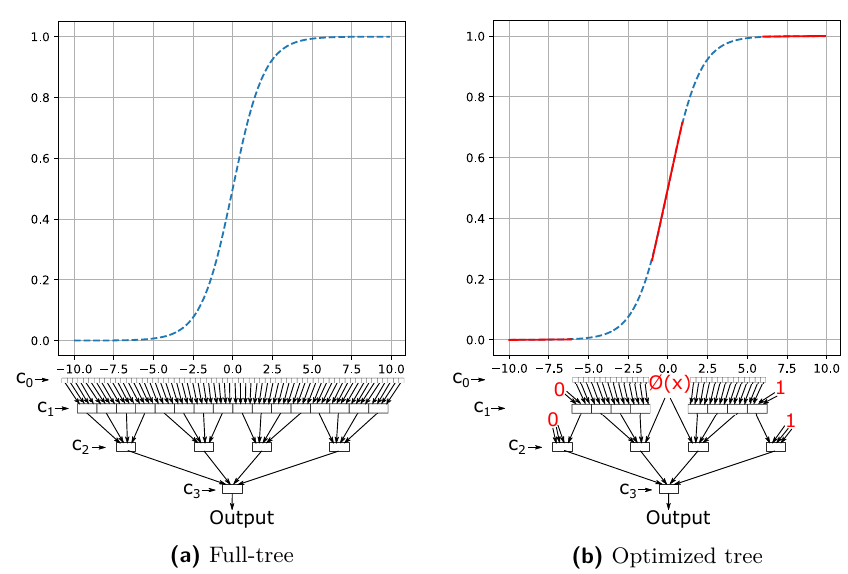
Figure 2: Evaluation of an 8-bit sigmoid function using the tree-based with base B =